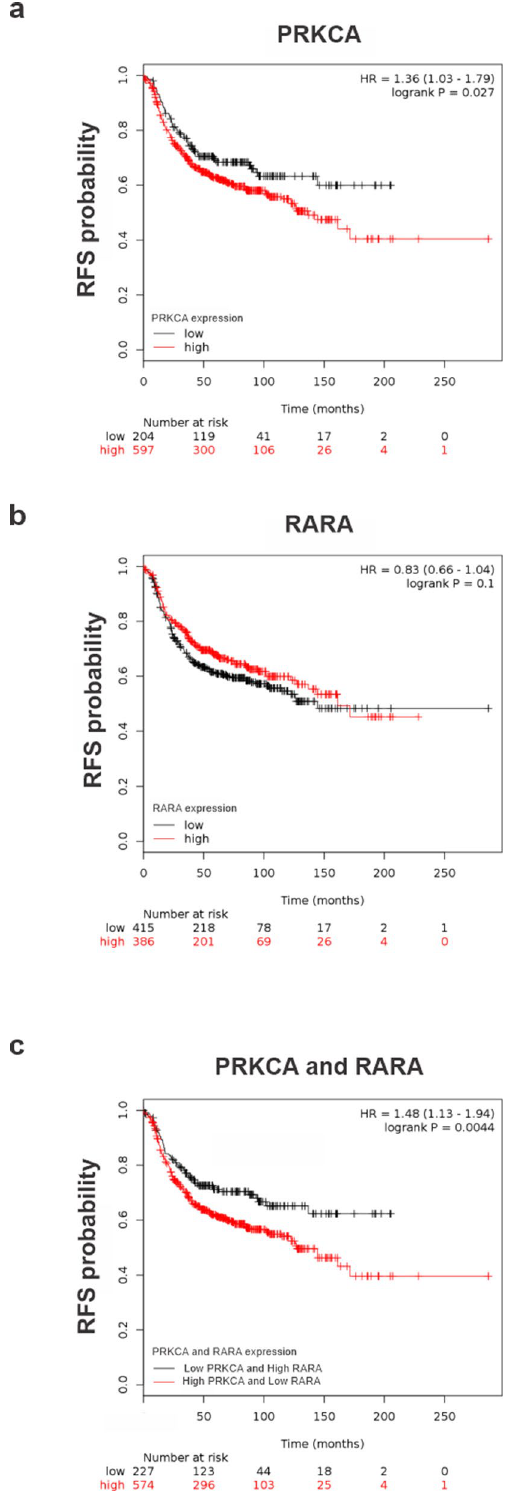
Figure 7. Bioinformatic analysis of PKCα (PRKCA) and RARα (RARA) mRNA expression. ( a ) Kaplan–Meier plots for PRKCA in negative estrogen receptor breast cancer cohorts. ( b ) Kaplan–Meier plots for RARA in negative estrogen receptor breast cancer cohorts. ( c ) Kaplan–Meier plots for the mean expression of RARA and PRKCA in negative estrogen receptor breast cancer cohorts. Log-rank p values and hazard ratios (HRs; 95% confidence interval in parentheses) are